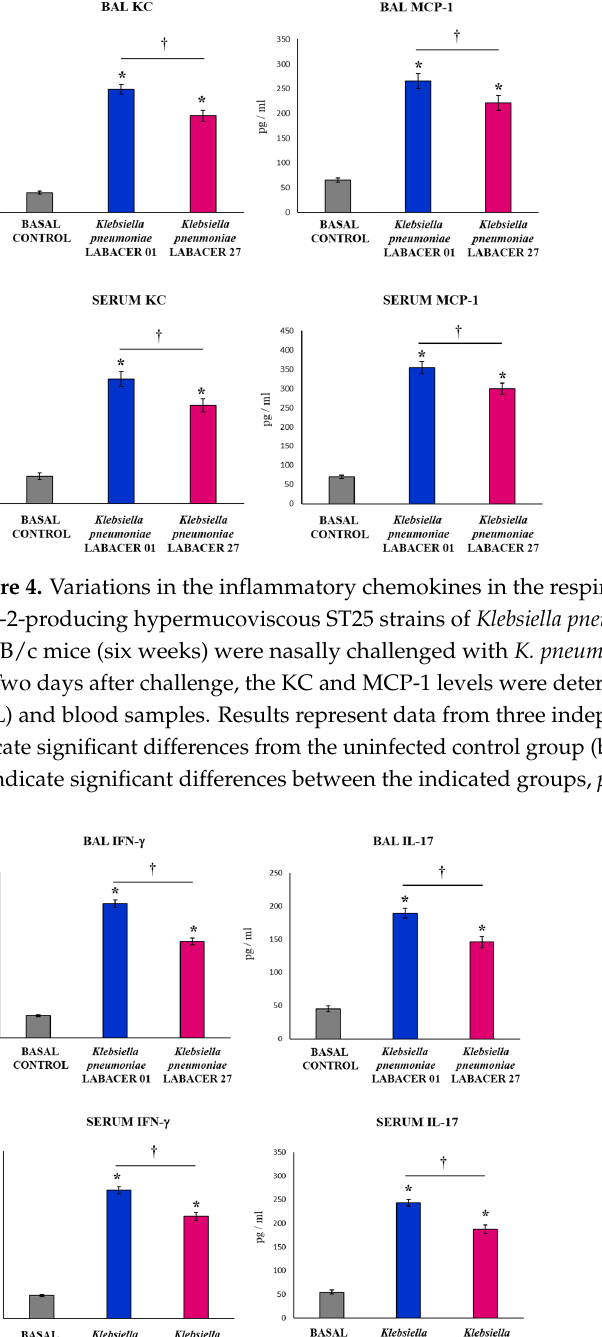
Figure 5. Variations in the inflammatory cytokines in the respiratory tract and blood induced by KPC-2-producing hypermucoviscous ST25 strains of Klebsiella pneumoniae . Immunocompetent adult BALB/c mice (six weeks) were nasally challenged with K. pneumoniae LABACER 01 or LABACER 27. Two days after challenge, the IFN- γ and IL-17 levels were determined in broncho-alveolar lavage (BAL) and blood samples. Results represent data from three independent experiments. Asterisks (*) indicate significant differences from the uninfected control group (basal control), p < 0.05. The crosses (†) indicate signi fi cant di ff erences between the indicated groups, p < 0.05.